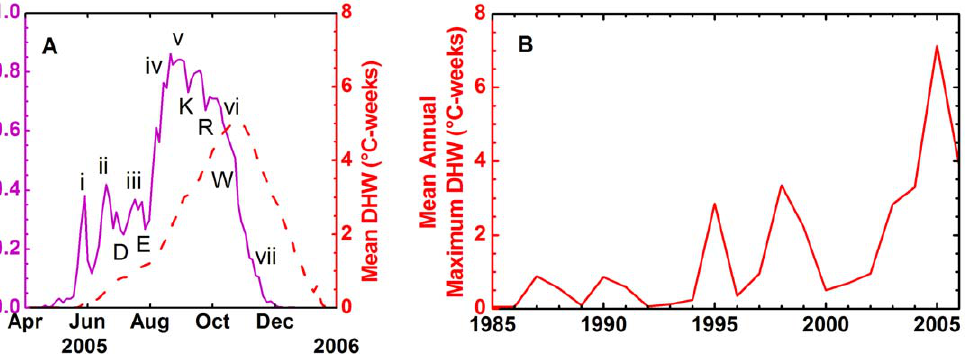
Figure 2. Temporal patterns of thermal stress in the Caribbean. Average of satellite-derived anomaly and thermal stress indices from the 0.5- degree pixels containing or nearest to reefs in the Caribbean (bounded by 35 u N, 55 u W, and the coast of the Americas). (A) NOAA coral bleaching HotSpots (purple) and DHW (red) in 2005. See results for explanations of (i)–(vii). Letters D–W refer to the major hurricanes of 2005: D ennis, E mily, K atrina, R ita and W ilma. (B) Average of annual maximum thermal stress (DHW) values during 1985–2006. Significant coral bleaching was reported during periods with average thermal stress above 0.5 u C-weeks, and was especially widespread in 1995, 1998, and 2005.